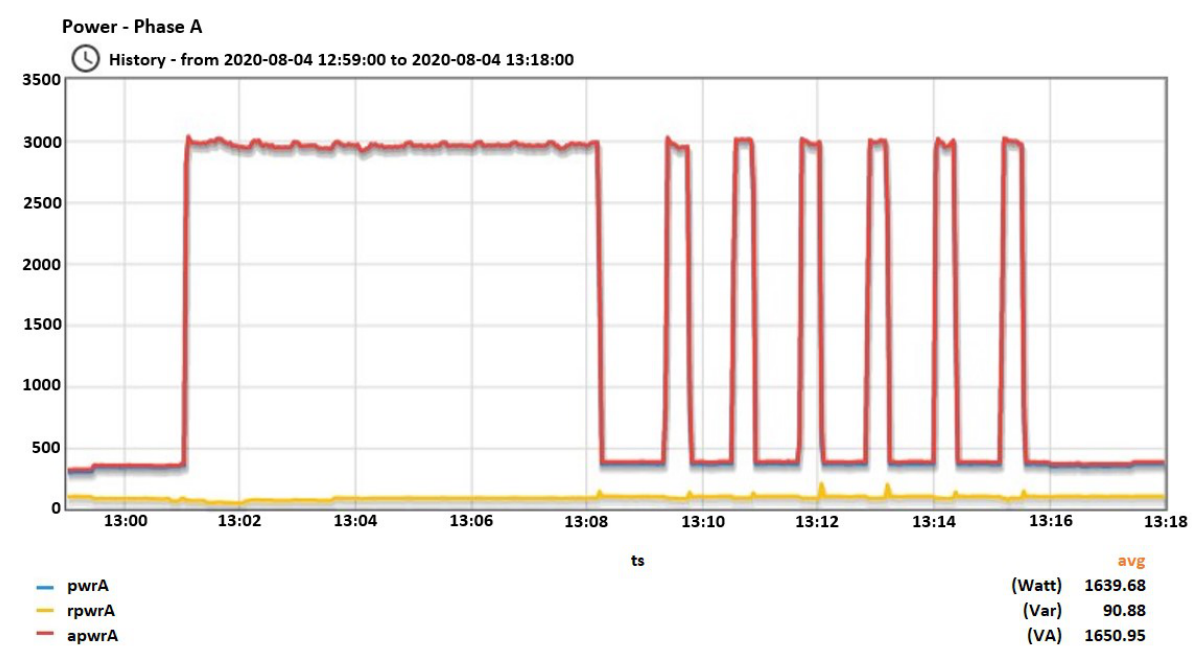
Figure 12. Oven’s behavior. The oven operated in a time period where no other device changed the state.